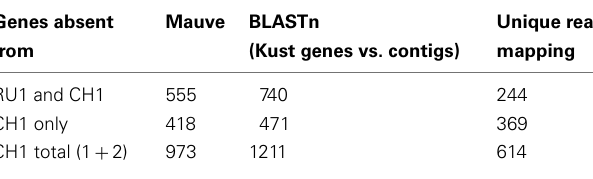
Table 1 | Number of Kust genes absent from the RU1 and CH1 assemblies analyzed by three independent methods.